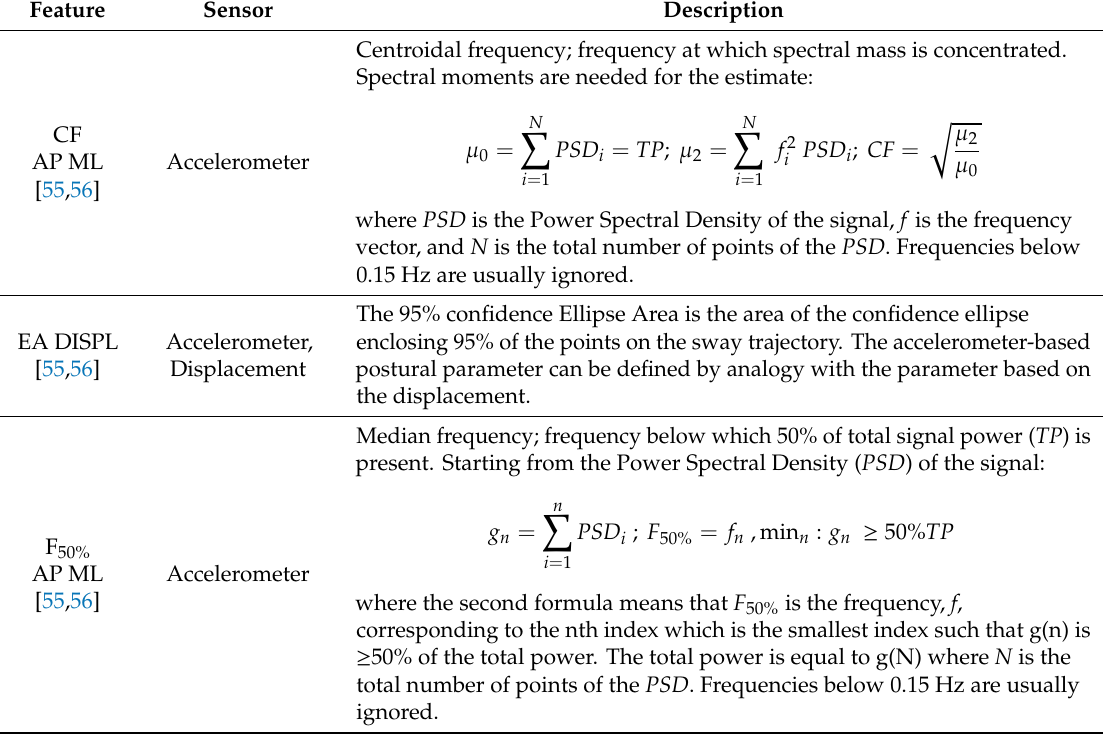
Table 2. Sensor-based features extracted from the QS